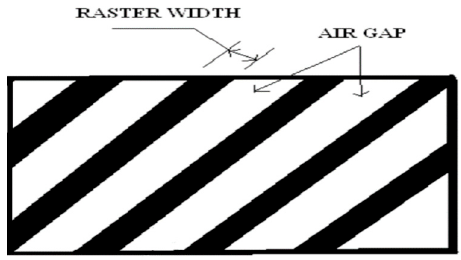
Figure 3. Raster width and air gap. 108